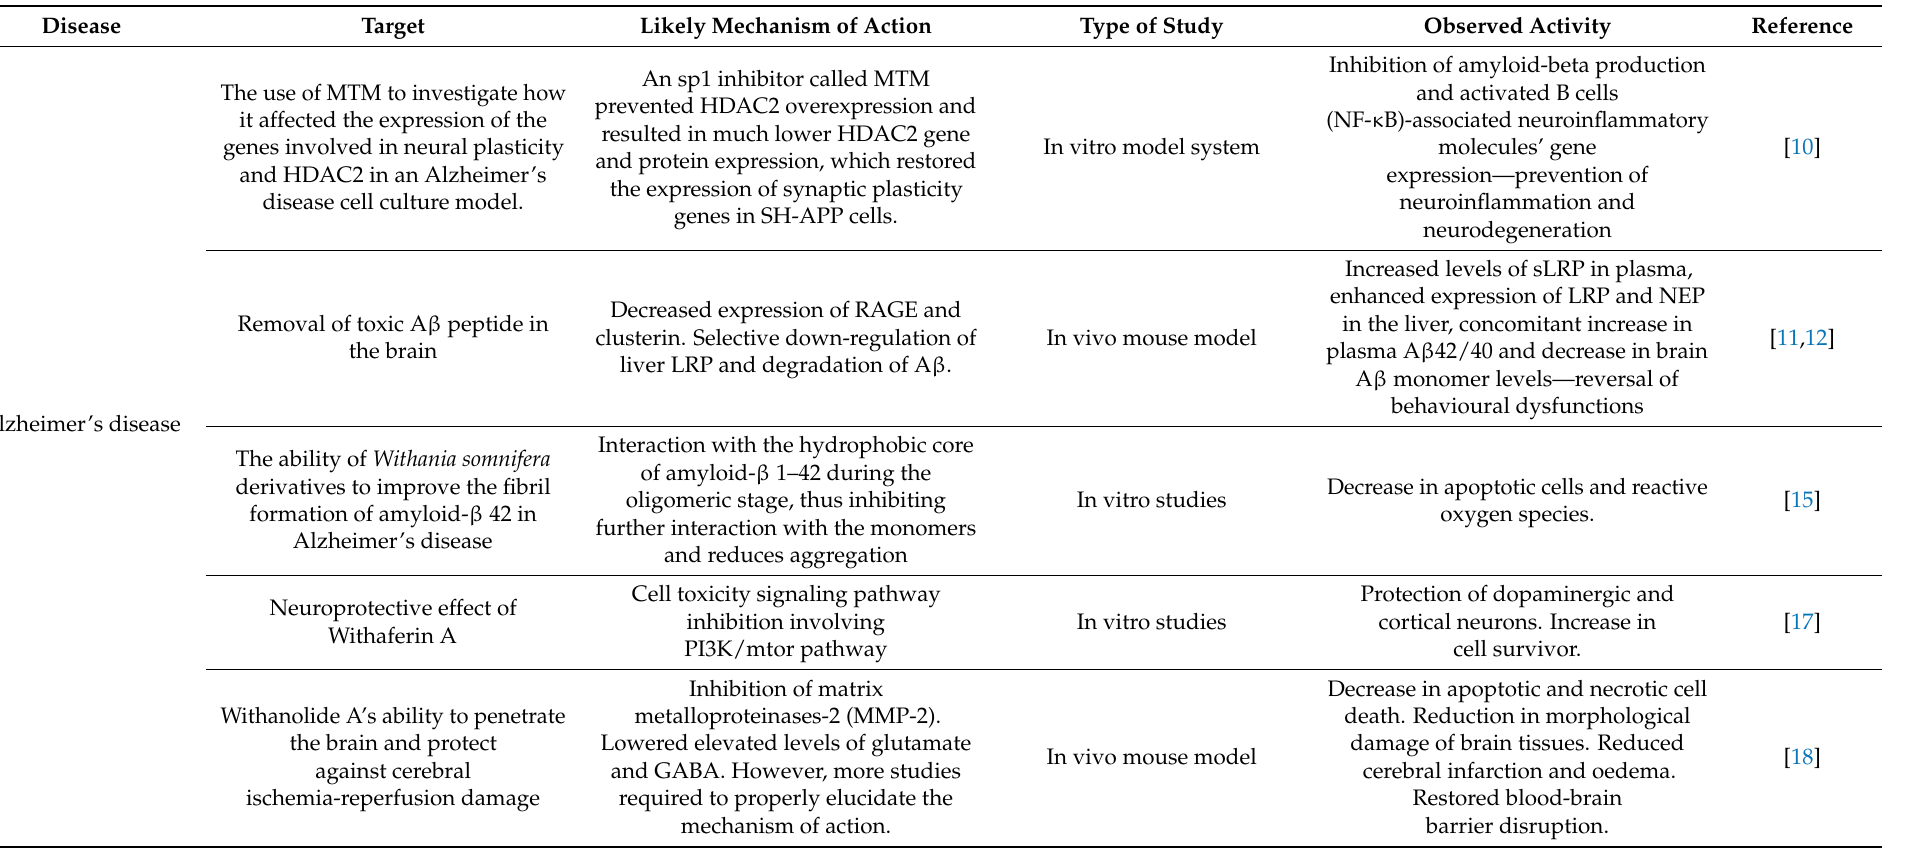
Table 1. Summary of the results of selected research studies on Ashwagandha (Withania somnifera)